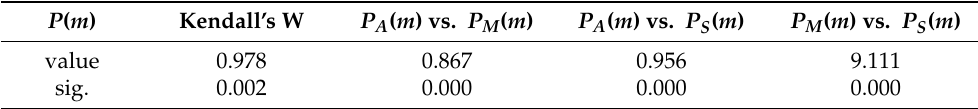
Table 9. Result of rank-concordance and rank-correlation analyses.